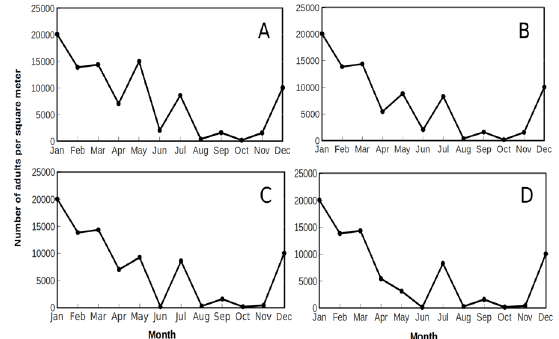
input. Lower section. Froghopper calc software,